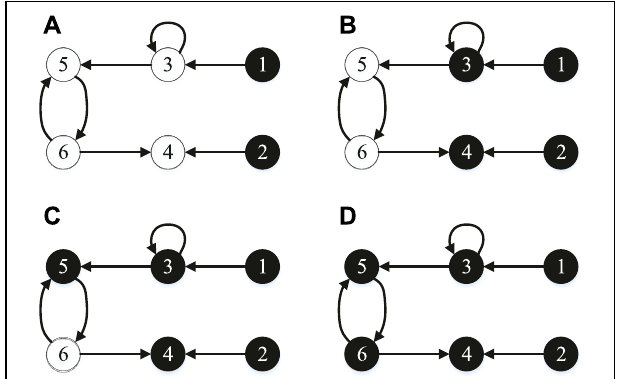
FIGURE 1 | A forcing process based on color change rule in a digraph with six nodes and seven edges. (A) A graph with drive node set V D = { v 1 , v 2 } ; (B) v 1 force v 3 to be black and v 2 force v 4 to be black; (C) v 3 force v 5 to be black; (D) v 5 force v 6 to be